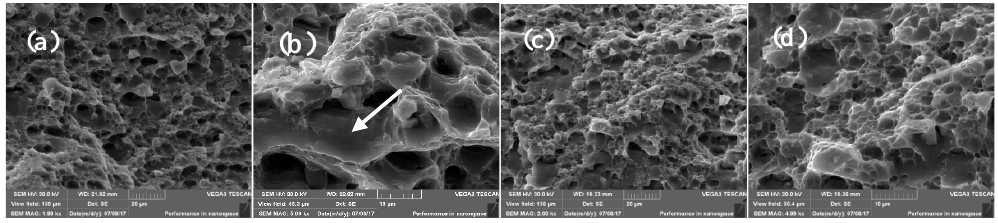
Figure 9. Fracture surface of the flame straightening: ( a , b ) top, ( c , d ) bottom.